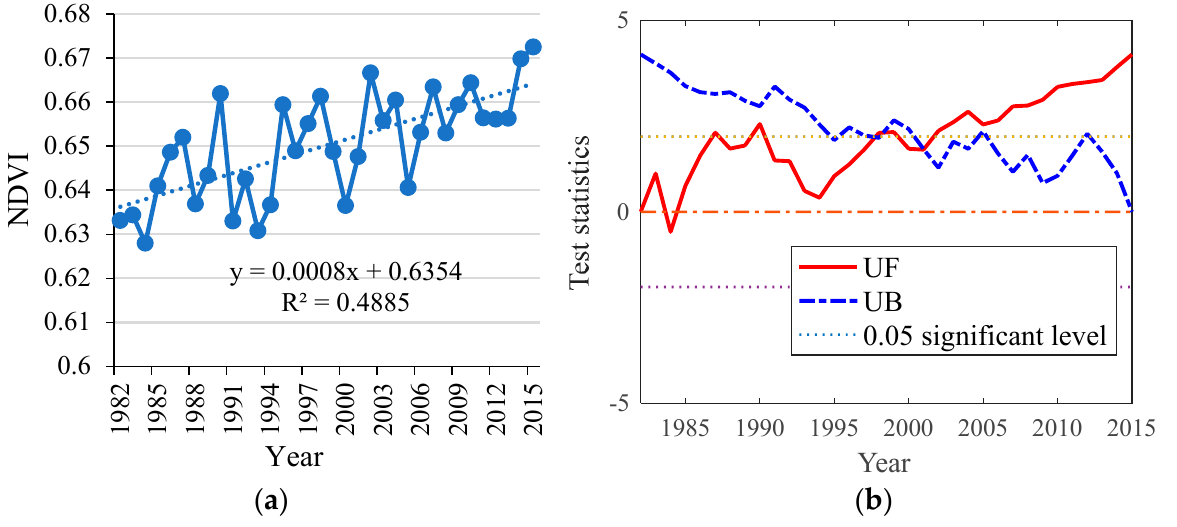
Figure 5. Temporal variation ( a ) and mutation detection ( b ) of the annual mean NDVI in the karst areas of Southwest China from 1982 to 2015.